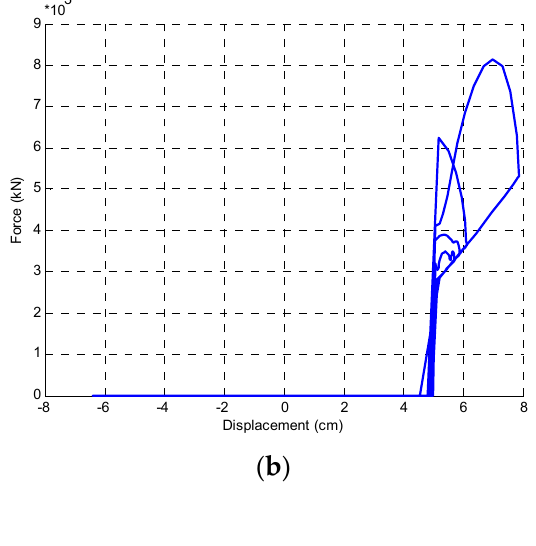
Figure 10. Lateral displacement time histories of each story in the non ‐ isolated model of a building during seismic excitation: ( a ) Parkfield; ( b ) Kobe; ( c ) San Fernando; ( d ) Tabas. The hysteresis loops of the rubber bumpers during impact, when the base level ex ‐ ceeds a relative displacement of 5 cm, are shown in Figure 11. The results indicate that the energy was absorbed by bumpers in order to control the lateral displacement of all stories. The peak values of the forces induced in bumpers were equal to: 15.55 × 10 3 kN, 8.15 × 10 3 kN, 4.85 × 10 3 kN and 10.40 × 10 3 kN for the Parkfield, Kobe, San Fernando and Tabas earthquakes, respectively. As can be clearly seen, impact occurred after the critical dis ‐ tance (5 cm) and energy had dissipated, as depicted by the hysteresis loops in Figure 11.